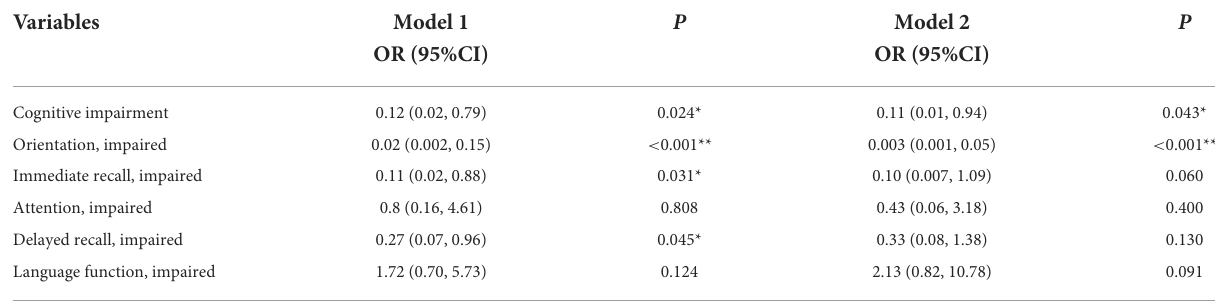
TABLE 2 Associations between walking speed and cognitive impairment and impaired cognitive domain function in men by binary logistic regression